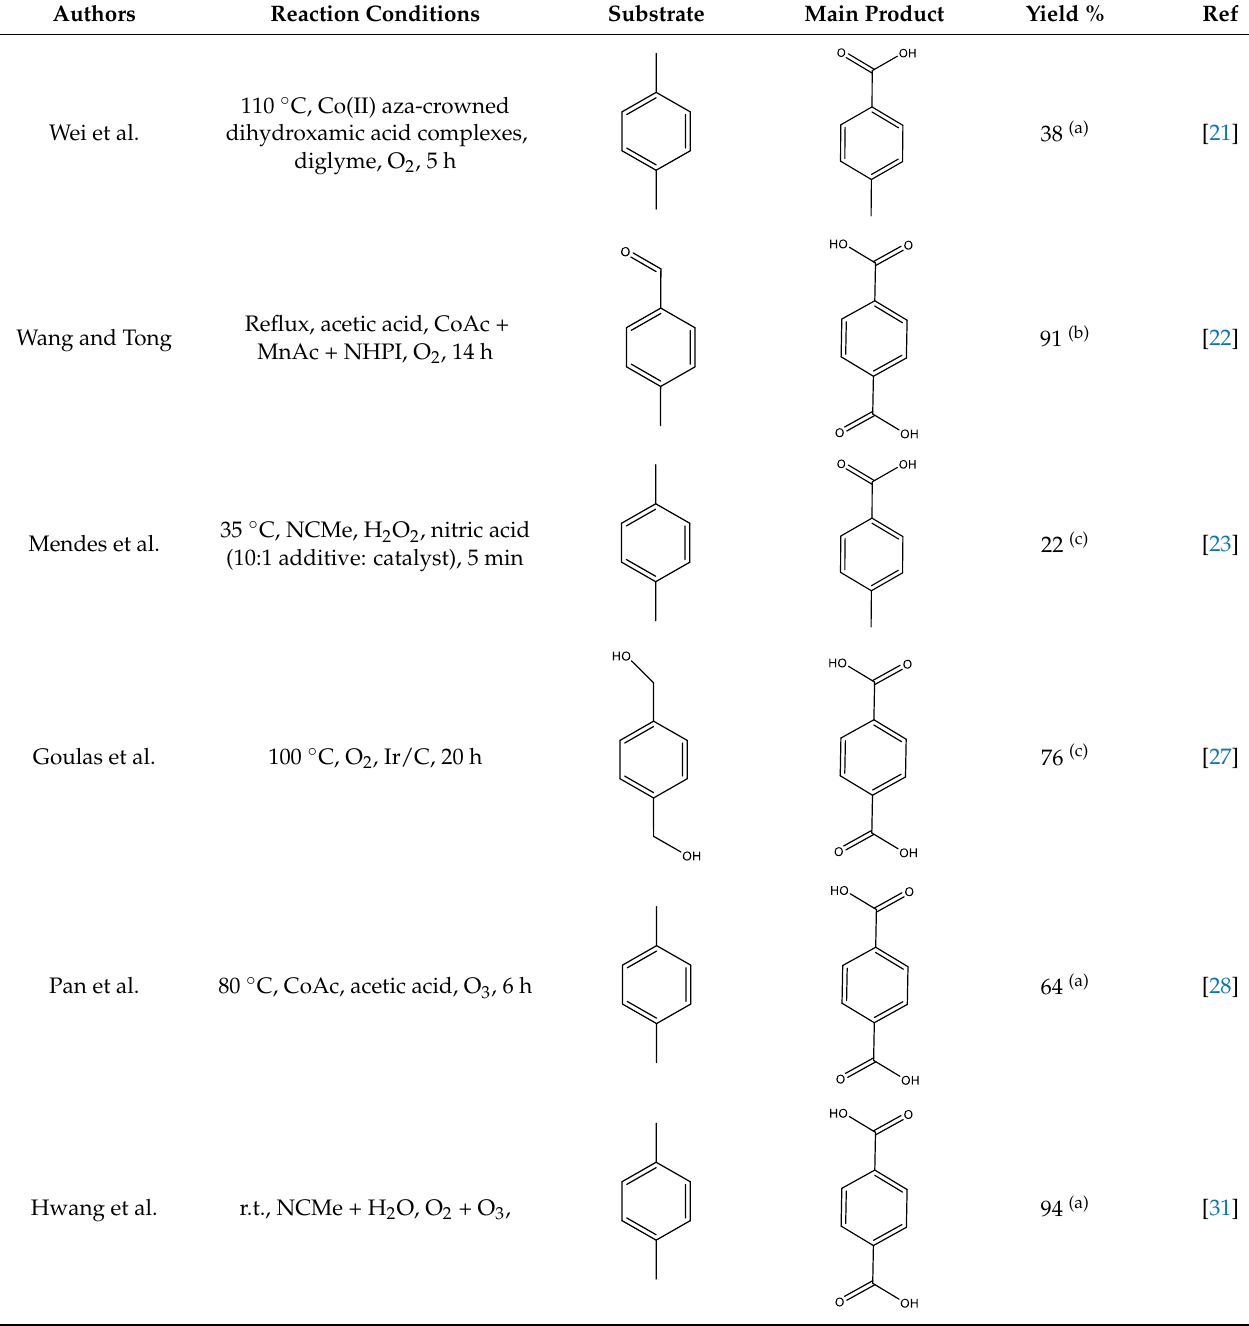
Table 1. Reaction conditions and best results for homogeneous catalysts focused on the oxidation of p- xylene or derivatives.